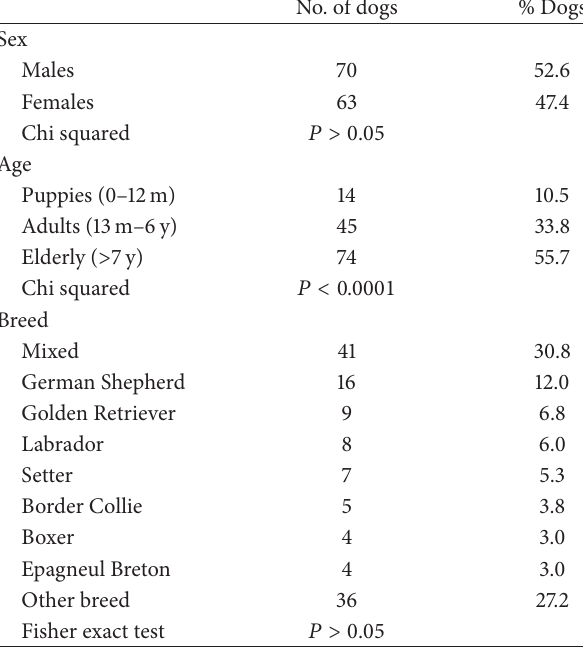
Table 1: Sex, age, and breed of dogs included in the initial survey (2,016 dogs—139 dogs with qRBCs = 6.89%) 3,958 CBCs were investigated and 154CBCs showed qRBCs (3.89%).